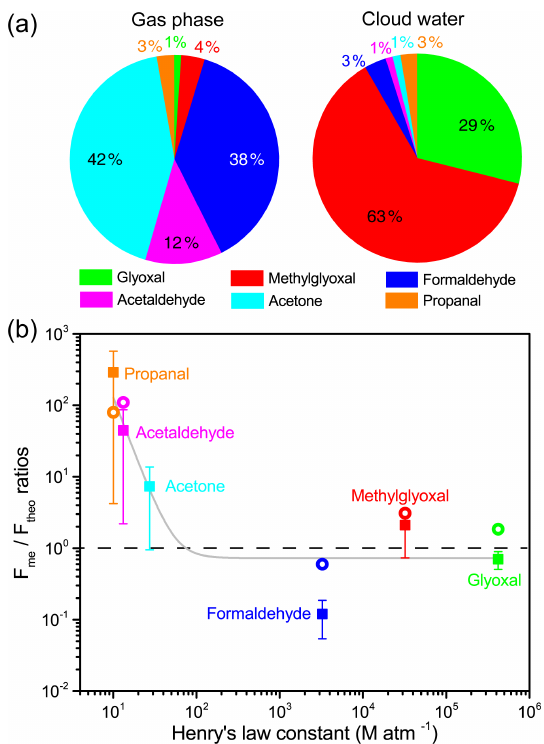
Figure 4. (a) Mass concentration fractions of measured carbonyl compounds in the gas phase and cloud water and (b) F me /F theo ra- tios as a function of Henry’s law constant ( K H ). Colored squares represent the mean F me /F theo ratios, and whiskers indicate the standard deviation. For comparison, F me /F theo ratios measured at Schmücke (van Pinxteren et al., 2005) are indicated by open circles. The gray fitted line shows the decreasing trend of F me /F theo ratios with an increasing Henry’s law constant for all species. The dashed line indicates the F me /F theo ratio of